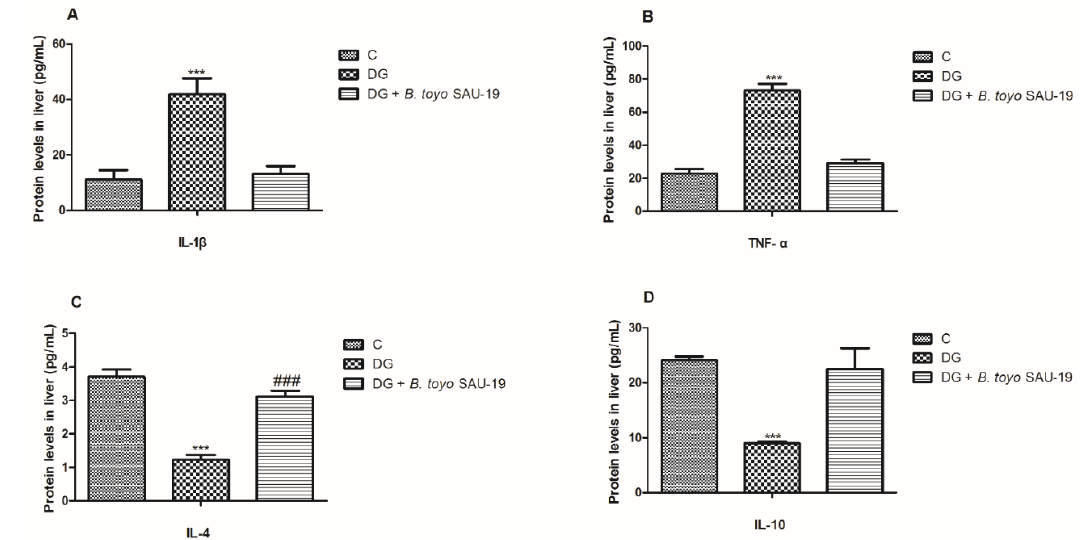
Figure 8. Effects of Bacillus toyonensis SAU-19 on relative protein expression (ELISA) of pro- and anti-inflammation-related cytokines in HFD/STZ-induced T2DM mice. ( A , B ) Protein (ELISA) expression levels of pro-inflammation cytokines. ( C , D ) Protein (ELISA) expression of anti-inflammatory cytokines. Values are shown as mean ± Sd. *** p < 0.05, DG compared with the control (C) and B. toyo SAU-19 groups. ### p < 0.05, B. toyo SAU-19 compared with the control (C) group ( n = 6).